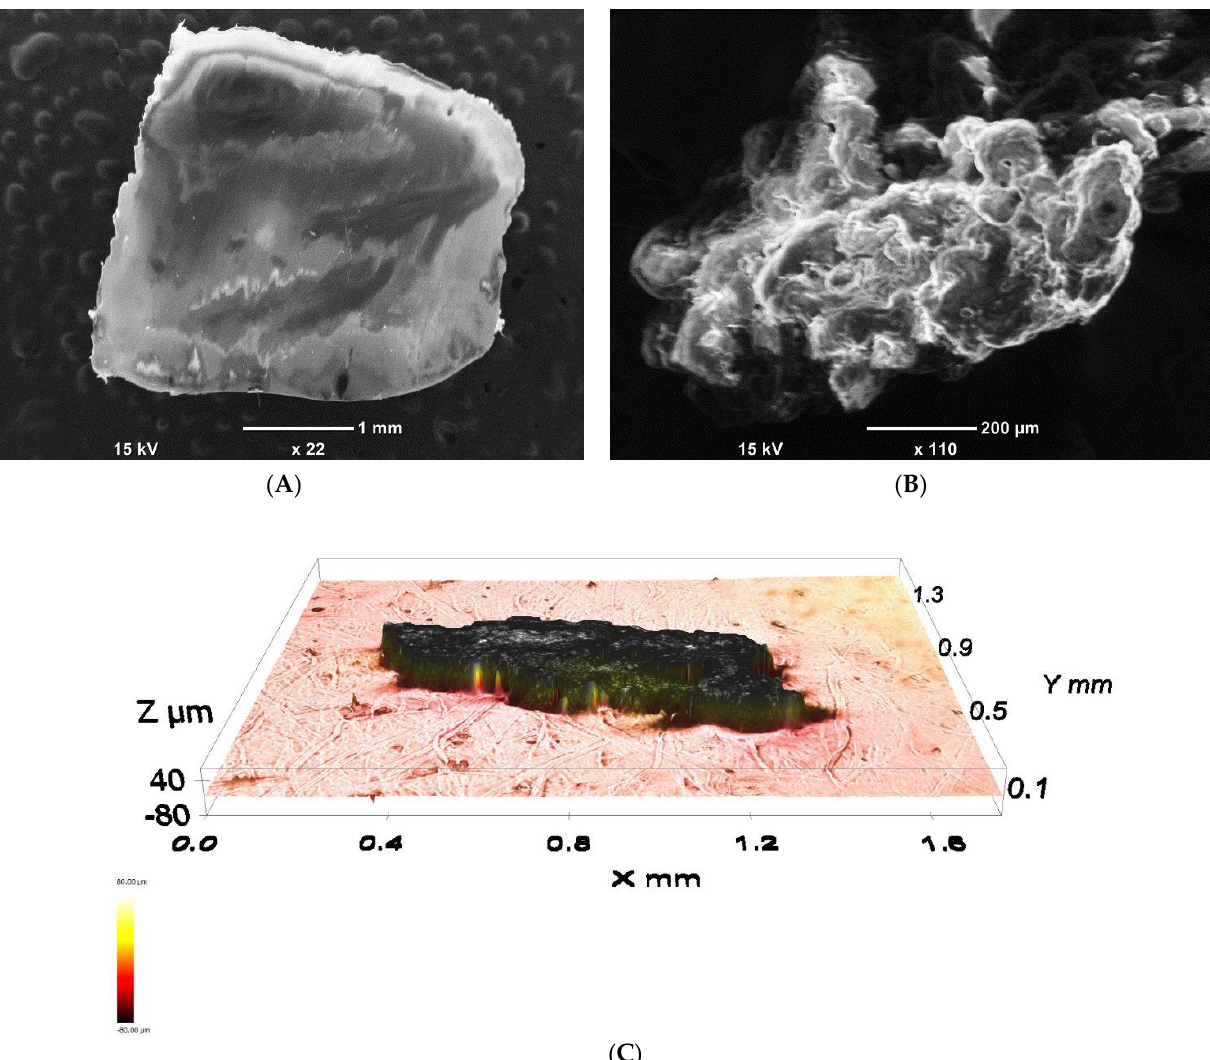
Figure 4. SEM micrograph of a common as-produced LDPE pellet ( A ) SEM micrograph; ( B ) and profilometry image ( C ) of LDPE powder prepared by grinding.